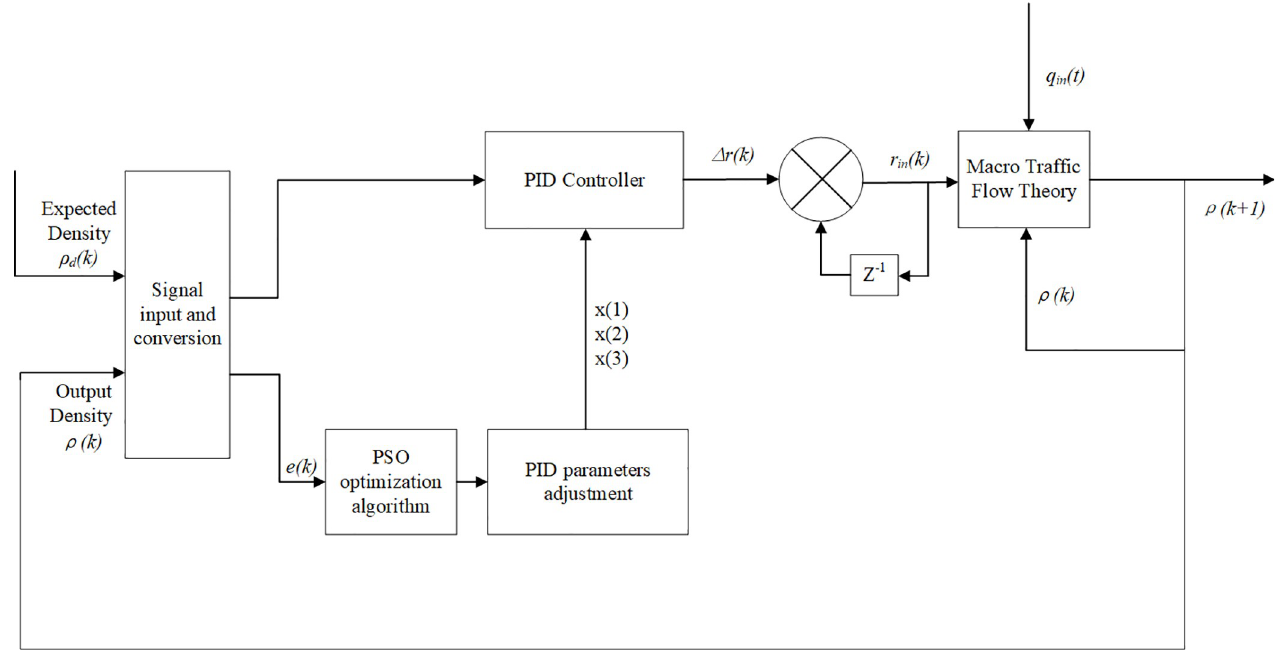
Fig 2. Flow chart of PSO-PID control system.